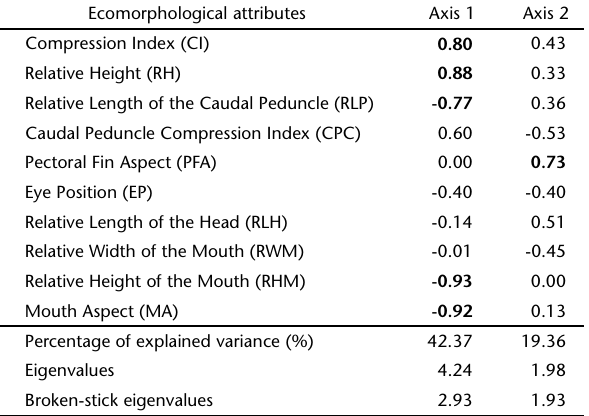
Table I. Factor loads from principal components analysis on ecomorphological attributes of four examined Characiformes fish species in Lajes Reservoir, Rio de Janeiro, Brasil.